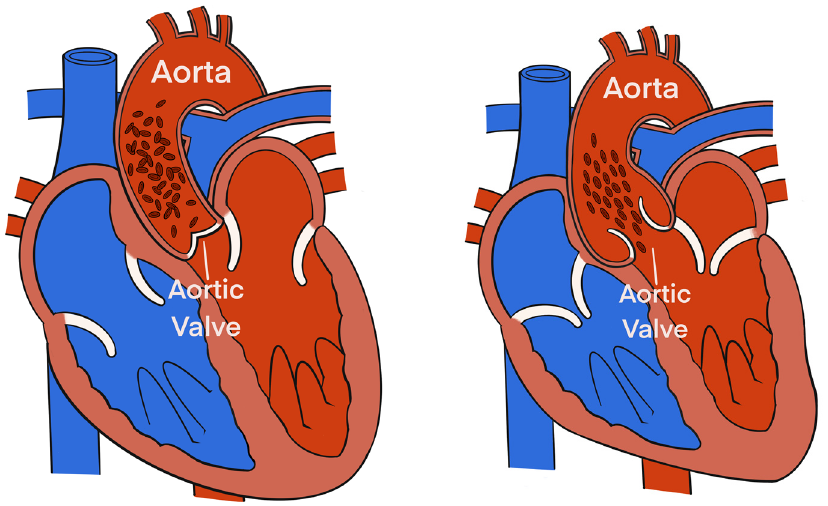
Figure 2. The alignment of the erythrocytes inside the aorta during a cardiac cycle induces significant variations in the impedance. During diastole, prior to aortic valve opening ( left ), the erythrocytes in the aorta are randomly oriented (due to no flow inside the aorta), which causes the applied electrical current to follow the circumference of the erythrocytes during their passage through the aorta resulting in a higher voltage and impedance measurement. During systole, after aortic valve opening ( right ), pulsatile flow causes the erythrocytes to parallelly align in the direction of the blood flow and the electrical current resulting in a lower impedance.